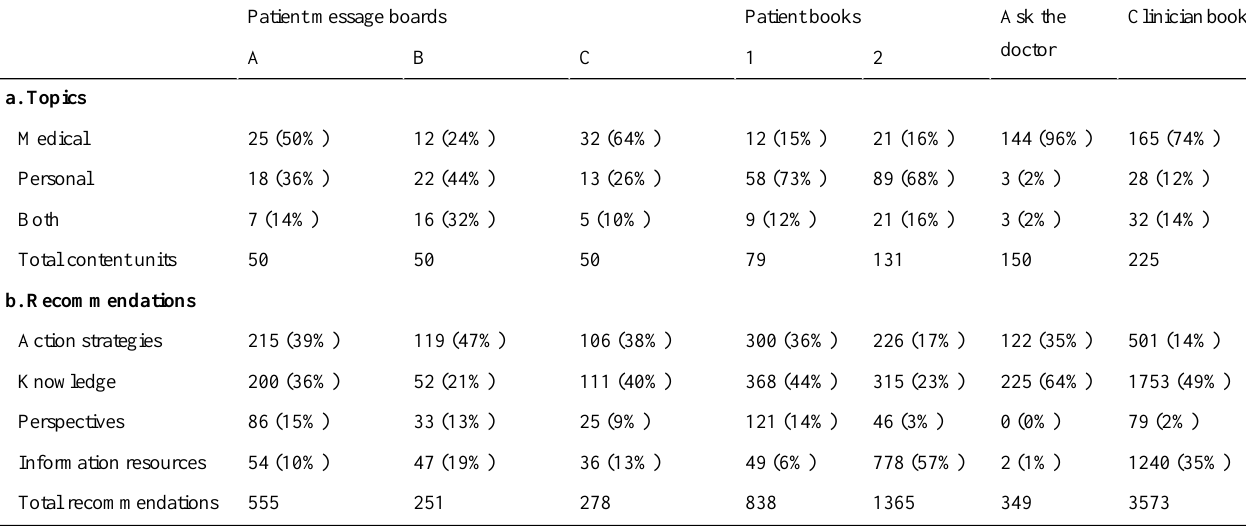
Table 4. Distribution of (a) topics and (b) recommendations across content sources (percentages reflect proportions from individual